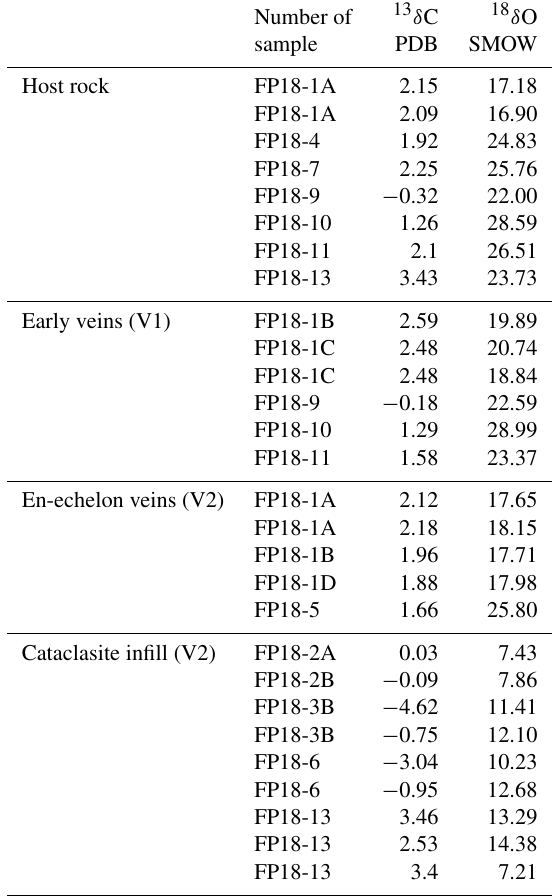
Table 1. Isotopic composition of analysed calcites. Stable isotope data from host rocks, calcite veins and cataclasite fillings of exten- sional faults. Number of 13 δ C